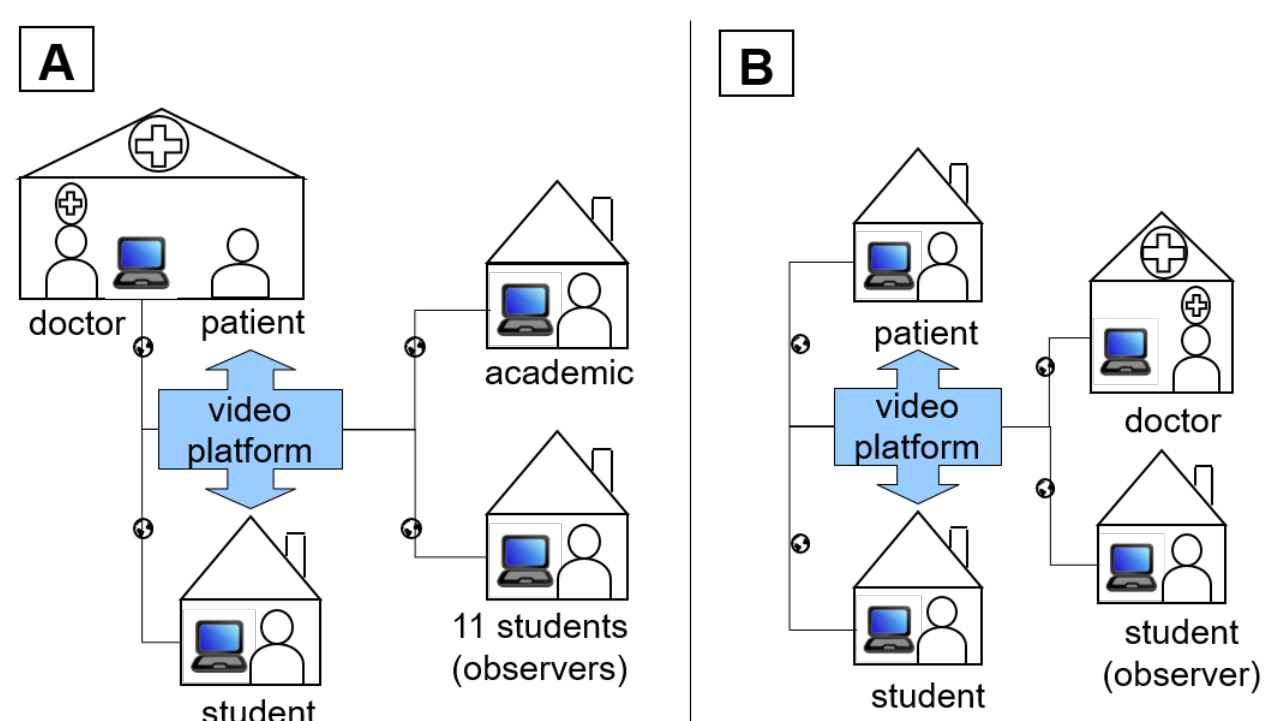
Figure 1. Spatial and personnel structure of group appointments/element A; ( A ) individual appoint- ments/element B ( B ).